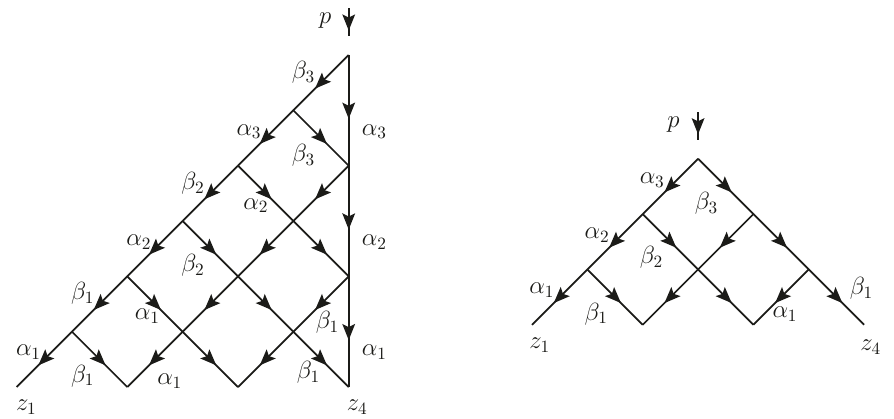
Figure 3 . Diagrammatic representation for the eigenfunctions of the open (left) and closed (right) homogeneous spin chains for N = 4. The indices are (cid:11) k = s